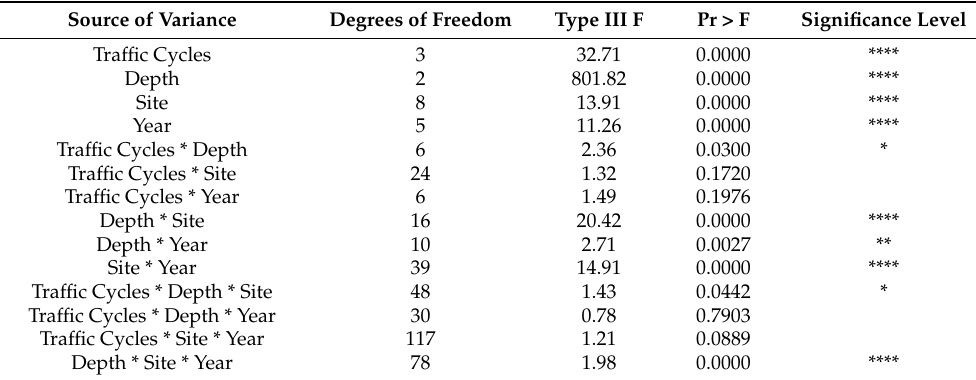
Table 3. Analyses of Variance of soil bulk density collected over a sampling period of 7 years (mixed ANOVA with depth and year as repeated factors).